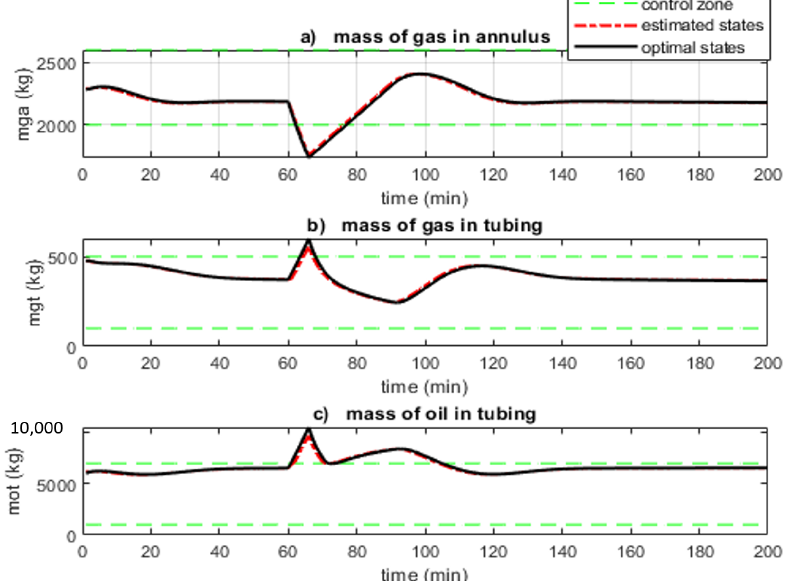
Figure 12. States of the gas-lift system with disturbance occurring between the 60th and 65th minutes. The NMPC restored the states to their zones after the disturbance made the states to temporarily violate the control